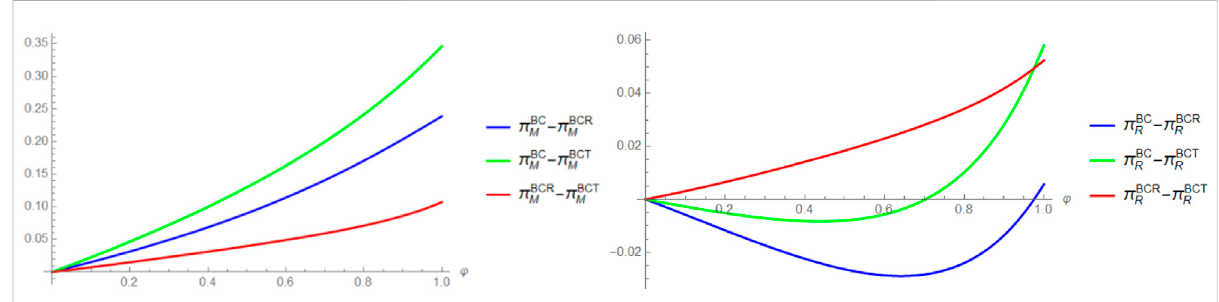
FIGURE 6 Comparison of the different manufacturer and retailer ’ pro fi ts in the scenario with adopting blockchain technology.